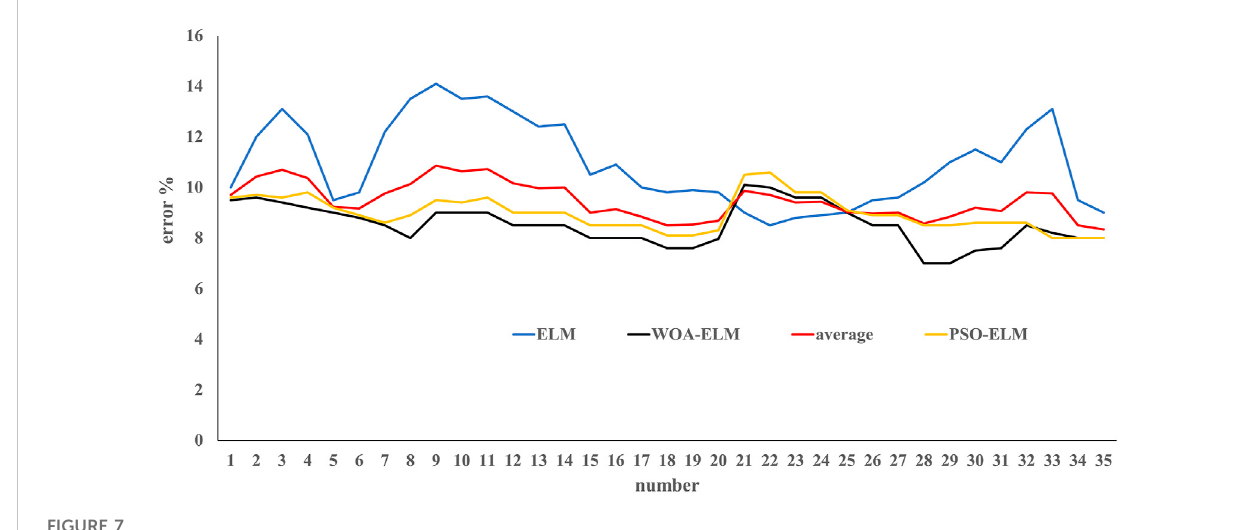
FIGURE 7 Comparative results of WOA-ELM, PSO-ELM, and traditional ELM models.